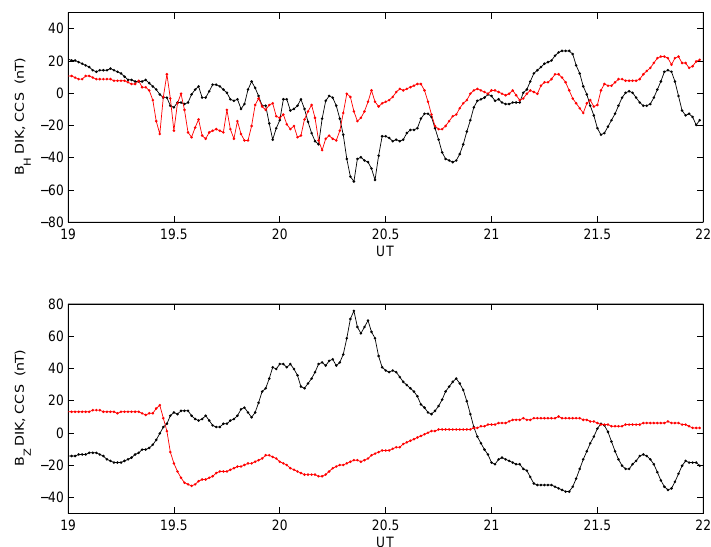
Fig. 4. The B H and B Z components measured by DIK (red) and CCS (black) of the AARI magnetometers. A negative bay in B H , with large oscillations, starts almost simultaneously with the dipolarization observed by TC-1, which has its magnetic footpoint near DIK; CCS shows no such oscillations. The B Z component shows a negative bay in DIK, however, a strong positive bay in